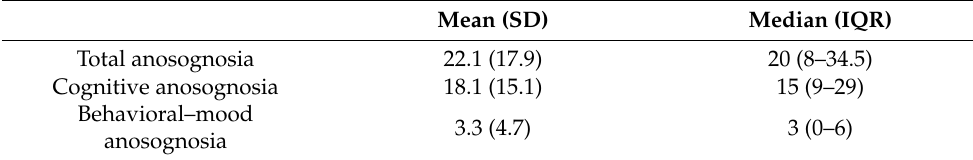
Table 2. Descriptive statistics for the anosognosia